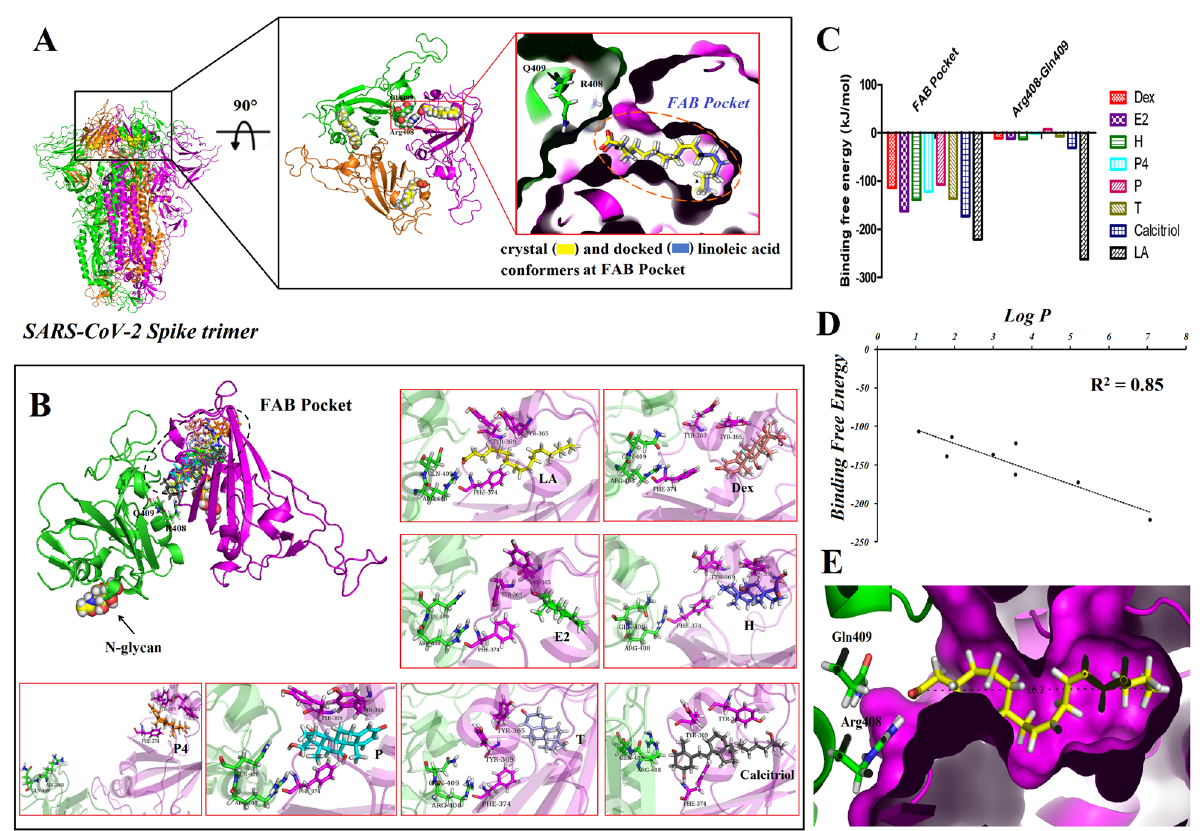
Figure 6. Interacting ligands to the fatty acid binding (FAB) pocket of spike glycoproteins in order to change Apo form to Locked S form. The Linoleic acid (LA) crystal structure (yellow) is superimposed over its docked conformer (blue) ( A ). The possible interaction of steroid molecules to the FAB pocket of spike ( B ). The result of binding free energy calculated by MM/PBSA methods for steroid molecules with the FAB pocket, and Arg408-Gln409 of spike glycoprotein during the last 10 ns of MD simulation ( C ). The correlation between Log P (lipophilicity) and the affinity of ligands to FAB site ( D ). ( E ) The length of FAB pocket (16.2 Å) which is occupied by ligands. DEX, dexamethasone; P4, progesterone, T, testosterone, E2, estradiol; H, hydrocortisone; P,